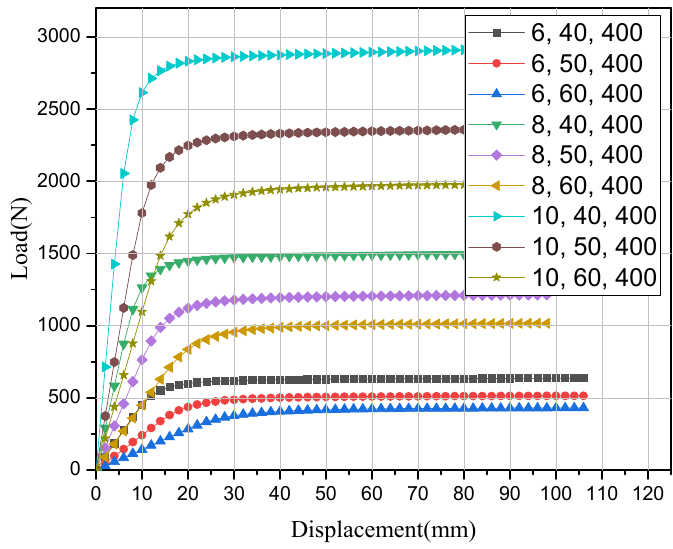
Figure 7. Load–displacement curves of SCDs ( n = 5).